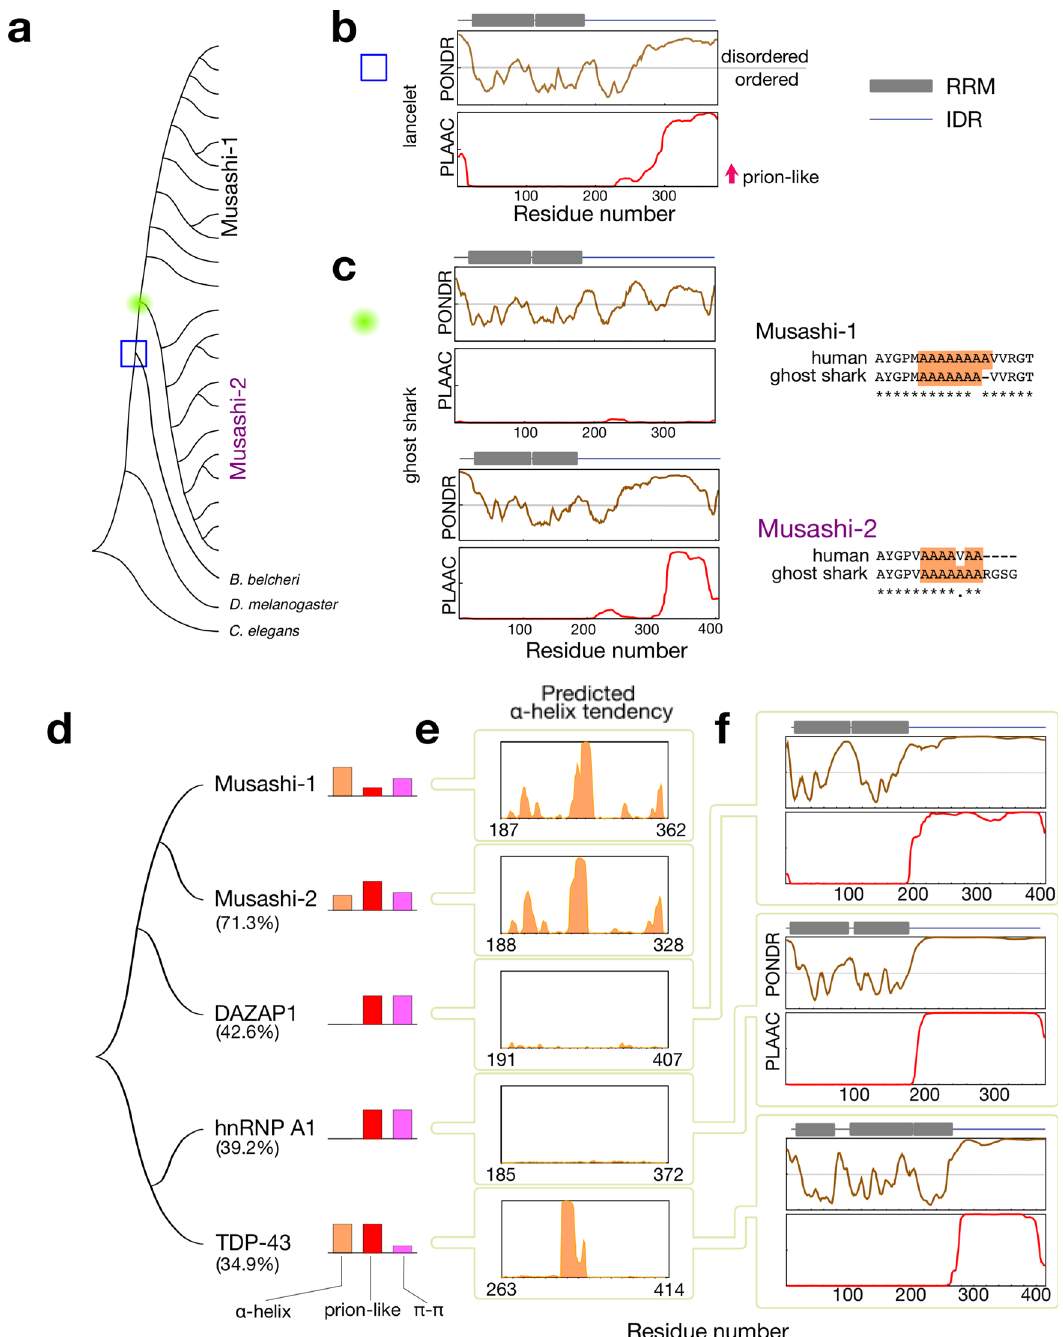
Fig. 6 Sequence analysis of the Musashi family in primitive model organisms and distantly related paralogs. a Phylogenetic tree of the Musashi family as shown in Fig. 1a with the additional lineages analyzed: a primitive chordate (the lancelet, blue box, panel ( b )) and a primitive vertebrate (the ghost shark, green circle, panel ( c )). b , c PONDR sequence disorder and PLAAC prion-likeness scores of b the lancelet ( Buccinum belcheri ) and c the ghost shark ( Callorhinchus milii ). The RNA recognition motifs (based on PROSITE analysis 73 ) are indicated by gray squares. The alignment of the polyalanine regions (highlighted in orange) of human and ghost shark Musashi proteins are also shown. d Phylogenetic tree of Musashi paralogs with high sequence similarity found in the human proteome. The percentages shown are the levels of sequence similarity. The importance of different drivers of assembly in their IDRs is indicated by colored bars representing their α -helical propensity (orange), prion-likeness (red), and the number of aromatic residues (purple). e α -helical propensity predicted using RaptorX 54 . f Sequence disorder and prion-likeness for DAZAP-1, hnRNP A1, and TDP-43 (c.f. Fig. 1b for Musashi-1 and −